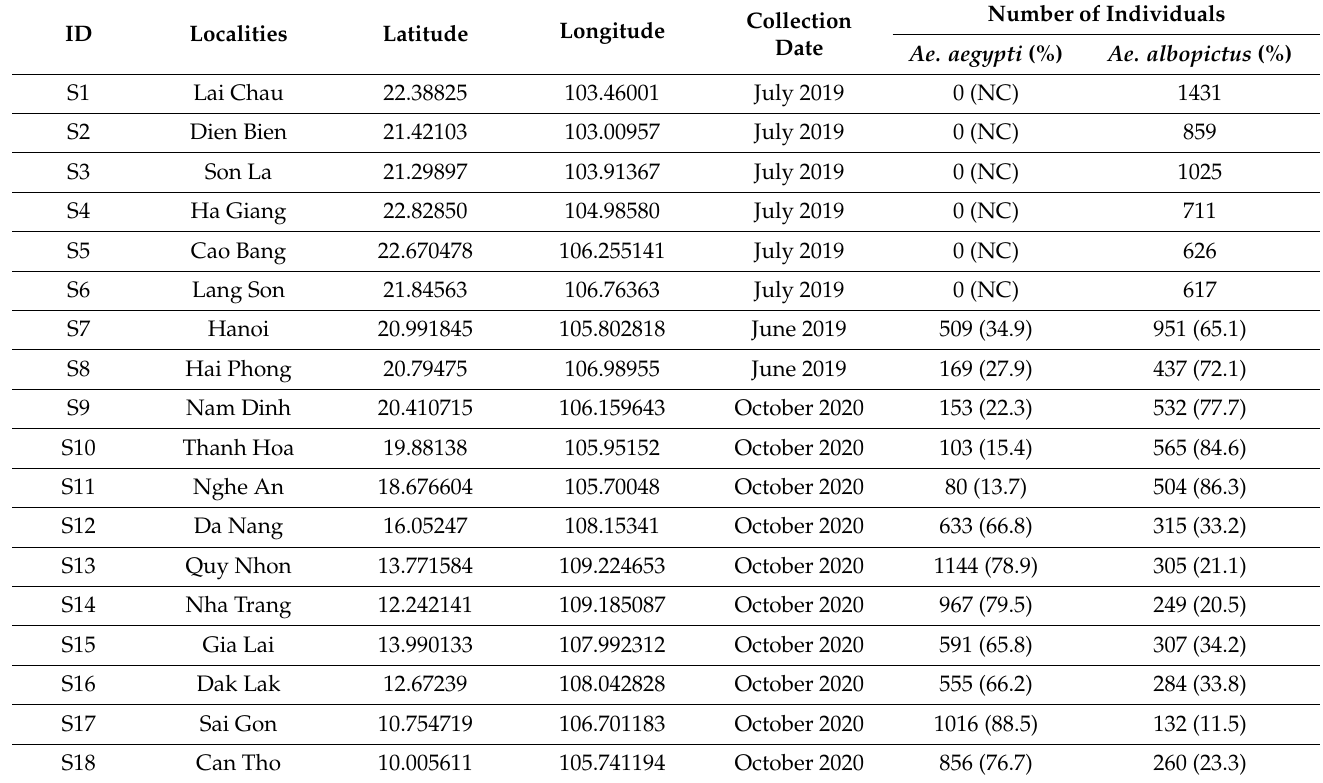
Table 1. Distribution of Aedes aegypti and Aedes albopictus specimens among 18 study sites in